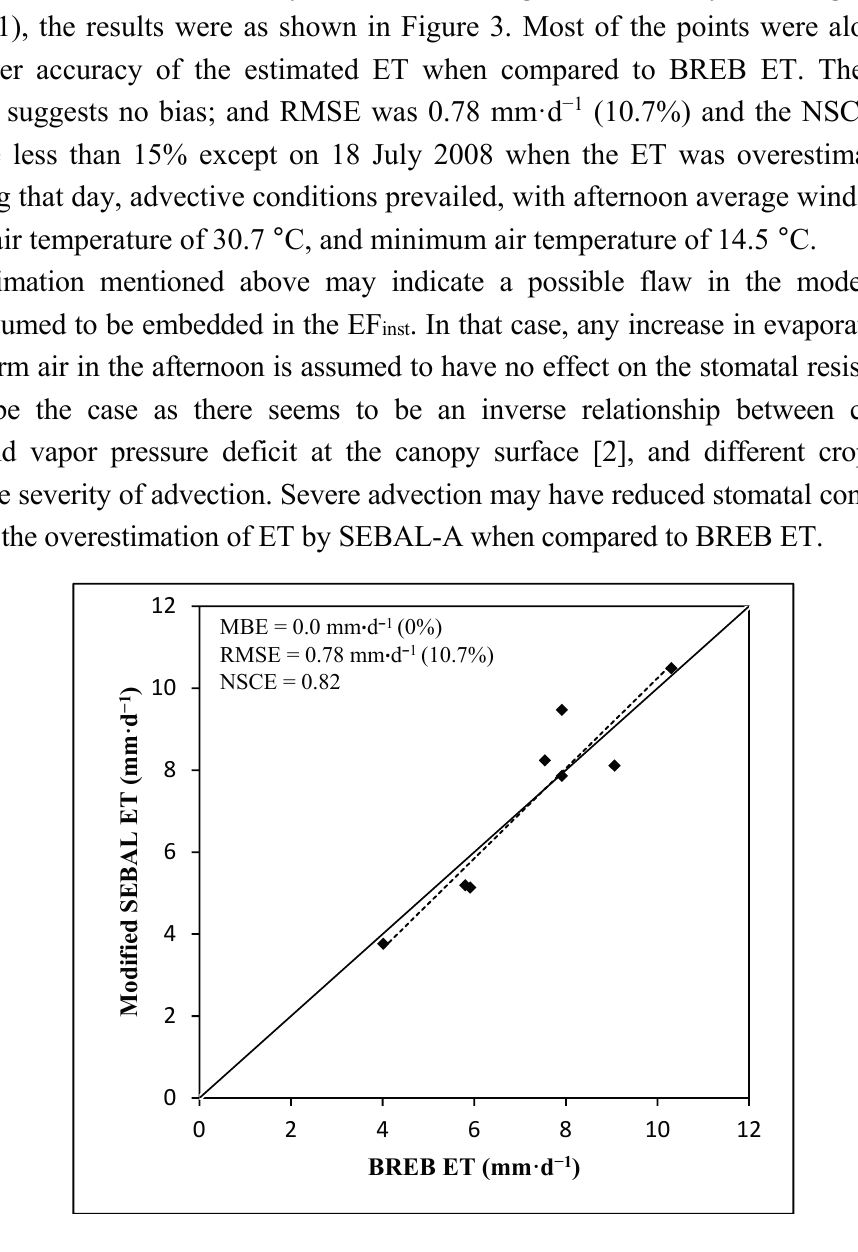
Figure 3. SEBAL-A crop ET compared to measured BREB ET for corn for non-stress full cover